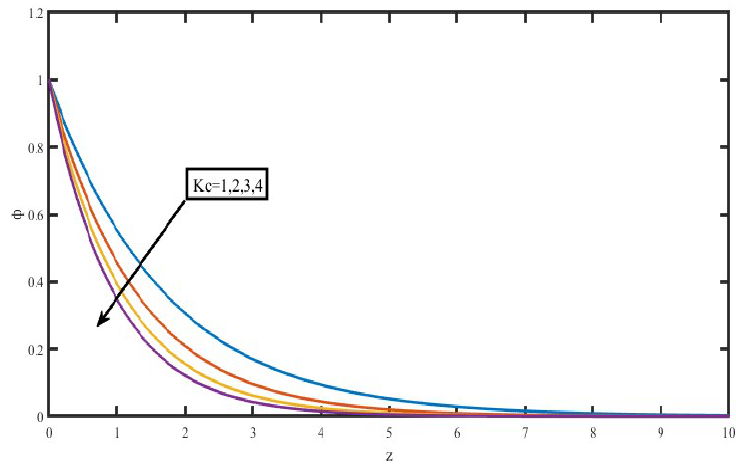
Figure 17. Concentration profiles for Chemical reaction (K c ).